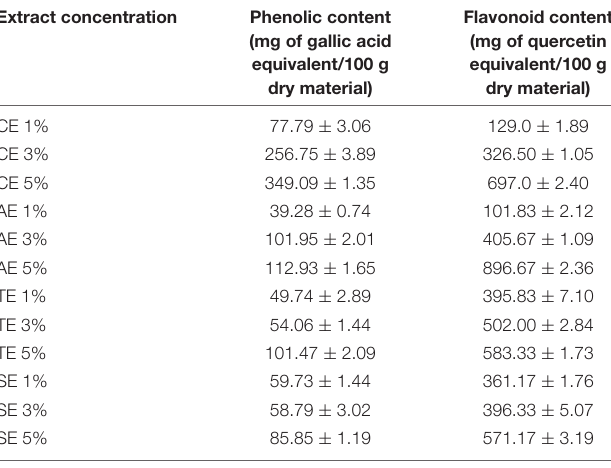
TABLE 1 | Total phenolic content in various concentrations of castor, artemisia, wheat, and sorghum extracts (CE, AE, TE, and SE,